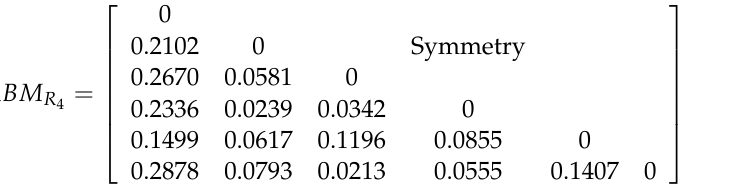
R 2 constructed with BPAs of R 2